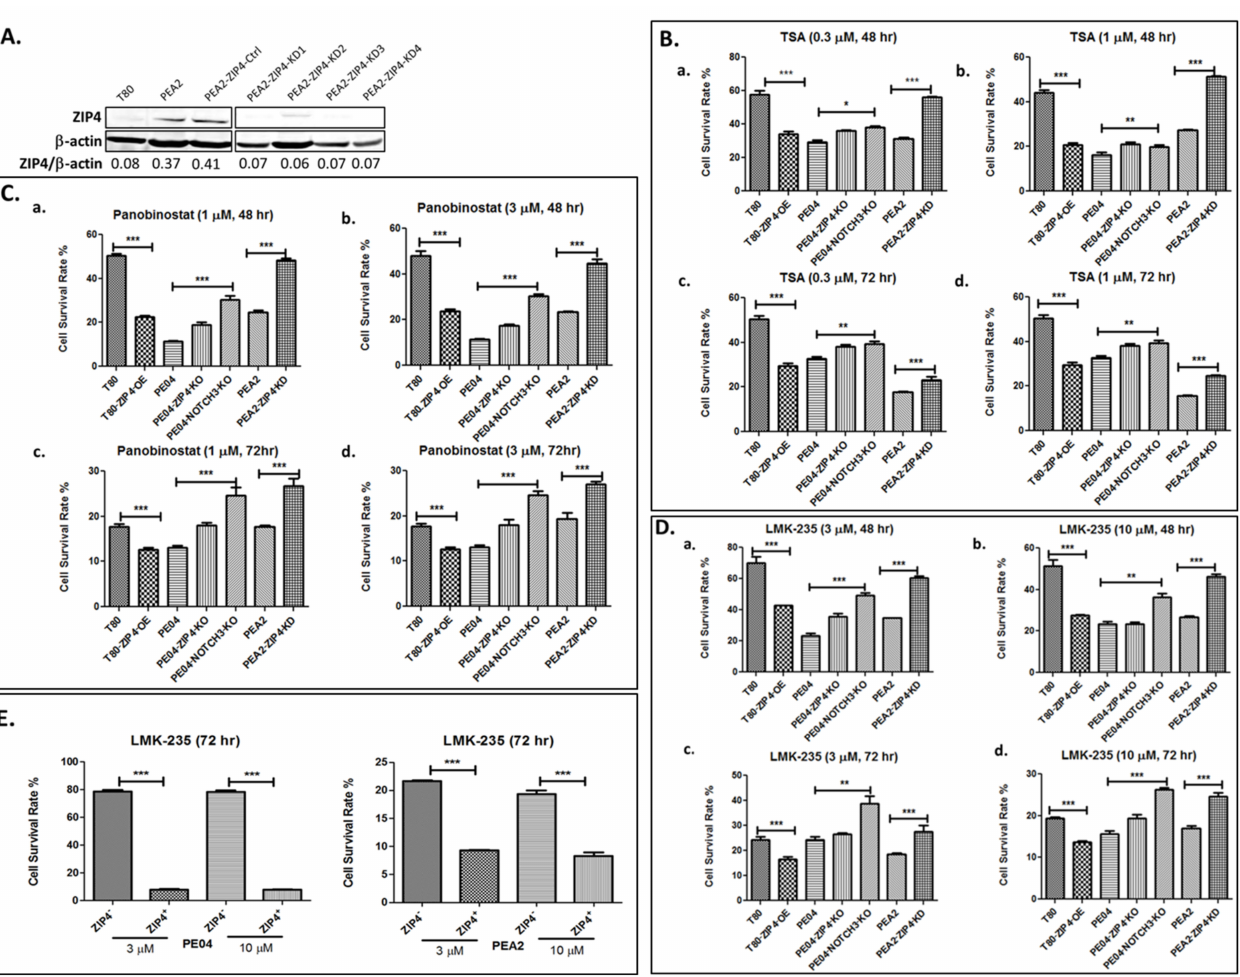
Figure 1. ZIP4 sensitized HDACi in HGSOC cells. ( A ). Established PEA2-ZIP4-KD cell lines. Other ZIP4-KO/KD, NOTCH3- KO cell lines used in this work were established and published previously [16,17]. The up- or downregulation of ZIP4 in these cell lines, including T80-ZIP4-OE, were confirmed and shown in Figure 2A. ( B – D ). ZIP4-OE in T80 (an immortalized human ovarian surface epithelial cell line) cells sensitized to TSA (0.3 and 1 µ M), PANO (1 and 3 µ M), and LMK-235 (3–10 µ M). ZIP4-KO/KD in both PE04 and PEA2 cells resulted in more resistance to HDACis-induced cell death. ( E ). FACS-sorted ZIP4 + cells respond to LMK-235 (3 and 10 µ M) significantly stronger than those ZIP4 − cells. The MTT values for each individual cell line with solvent treatment were used as 100% in all results shown in this figure. All experiments were repeated three times and presented as means standard deviation (SD). * p < 0.05; ** p < 0.01; *** p < ≥ ±